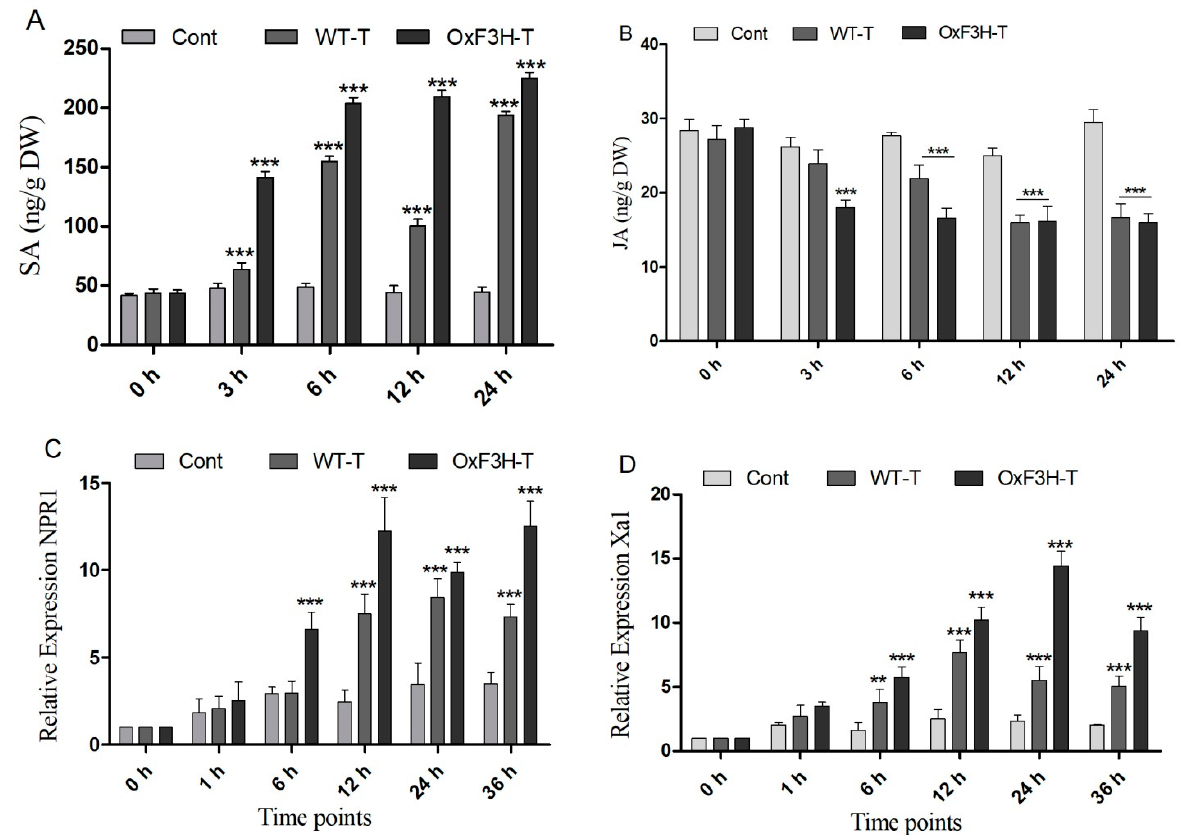
Figure 6. SA and JA signaling and PR gene expression. ( A ) SA and ( B ) JA accumulation in the control, WT, and OxF3H plants at different time points after Xanthomonas oryzae pv. Oryzae inoculation. ( C , D ) Relative expression of NPR1 and Xa1 genes, respectively, under BLB stress using actin as a reference gene. Bars indicate mean ± standard deviation and ** shows p ≤ 0.01 and *** shows p ≤ 0.001 significant difference, as analyzed using two-way ANOVA and a Bonferroni posttest.